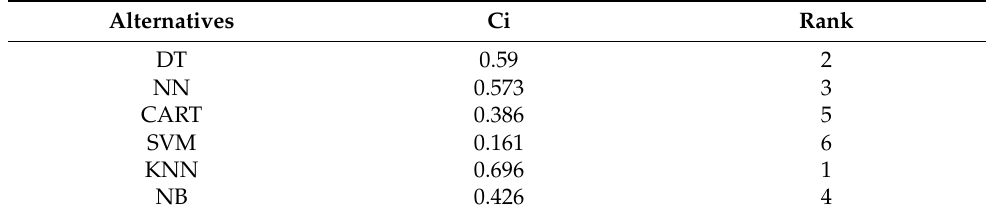
Table 9. Summary of Closeness coefficient data.